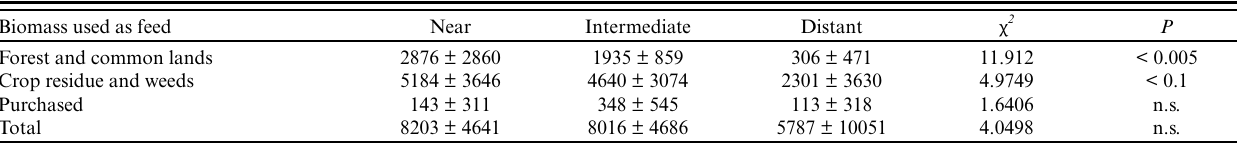
Table 6 . Comparison of the mean quantity of biomass in kg farm -1 year -1 from different sources used as livestock feed in the three zones of the study area (near, intermediate, and distant to Munesa Forest). Standard errors are given after the “±” signs. χ 2 and P values are given for Kruskal–Wallis tests that compared medians between the three